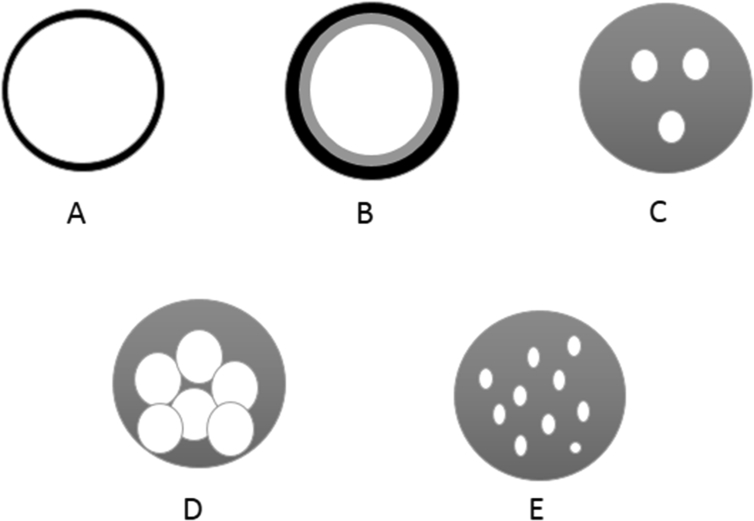
Microcapsules morphology: (A) Simple, (B) Multiwall, (C) Multi-core, (E) Aggregate and (E) Matrix (Adapted from Mishra, 2016).